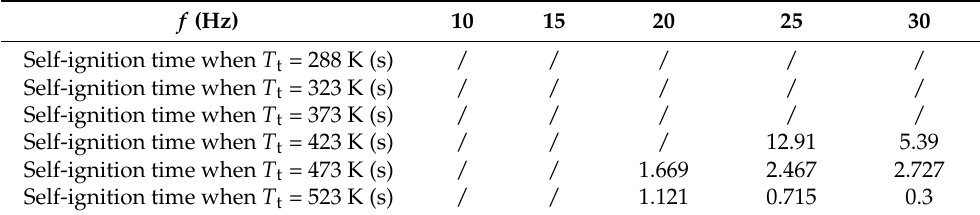
Table 3. Self-ignition time at different working conditions.